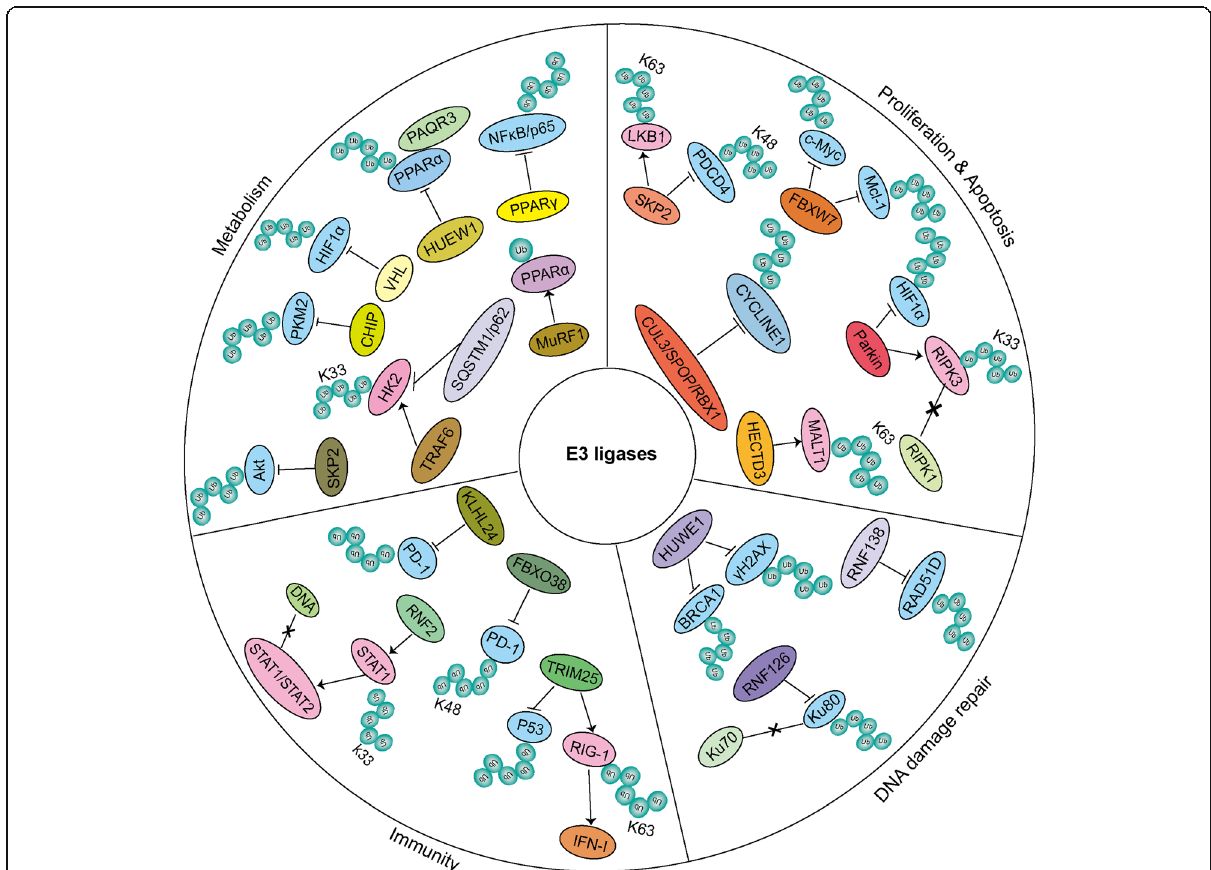
Fig. 4 Multi-functions of E3 ligases. Based on the different E3 ligases and their specific substrates, E3 ligases can involve in many different cellular progression such as proliferation, apoptosis, DNA damage repair, immunity and metabolism. We have shown some E3 ligases mentioned in this review and how they function in regulating cancer cell progression. For example, the E3 ligases FBXW7, HECTD3, CUL3/SPOP/RBX1, Parkin, SKP2 are involved in regulating proliferation or apoptosis through targeting proliferation-associated proteins for ubiquitination. E3 ligases HUWE1, RNF126, RNF138 are shown to regulate cancer cell DNA damage repair by targeting specific substrates for ubiquitination. E3 ligases FBXO38, KLHL22, TRIM25, RNF2 regulate cancer cell immune response through promoting ubiquitination of specific substrates. And E3 ligases PPAR γ , SKP2, CHIP, VHL, TRAF6, HUEW1,MuRF1 are capable of mediating cancer cell metabolism by targeting related substrates for ubiquitination. Note:we use different background colors to distinguish each E3 ligases. Blue background represents the genes they target for degradation and pink background represnets genes they target for stabilization or others but not degradation. We use × to show the disruption of protein-protein